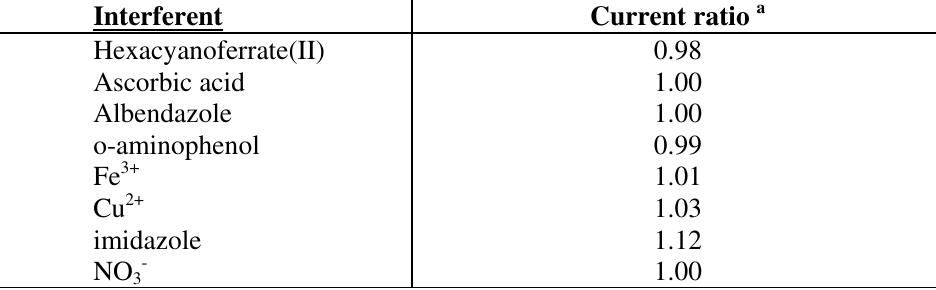
Table 2 Possible interferences tested with the